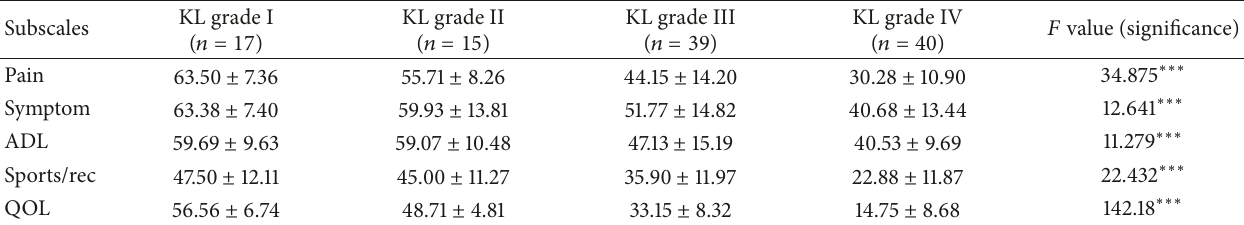
Table 3: Urdu KOOS subscale score for four radiographic OA knee patient groups based on Kellgren-Lawrence (KL) grading. KL grade I Subscales